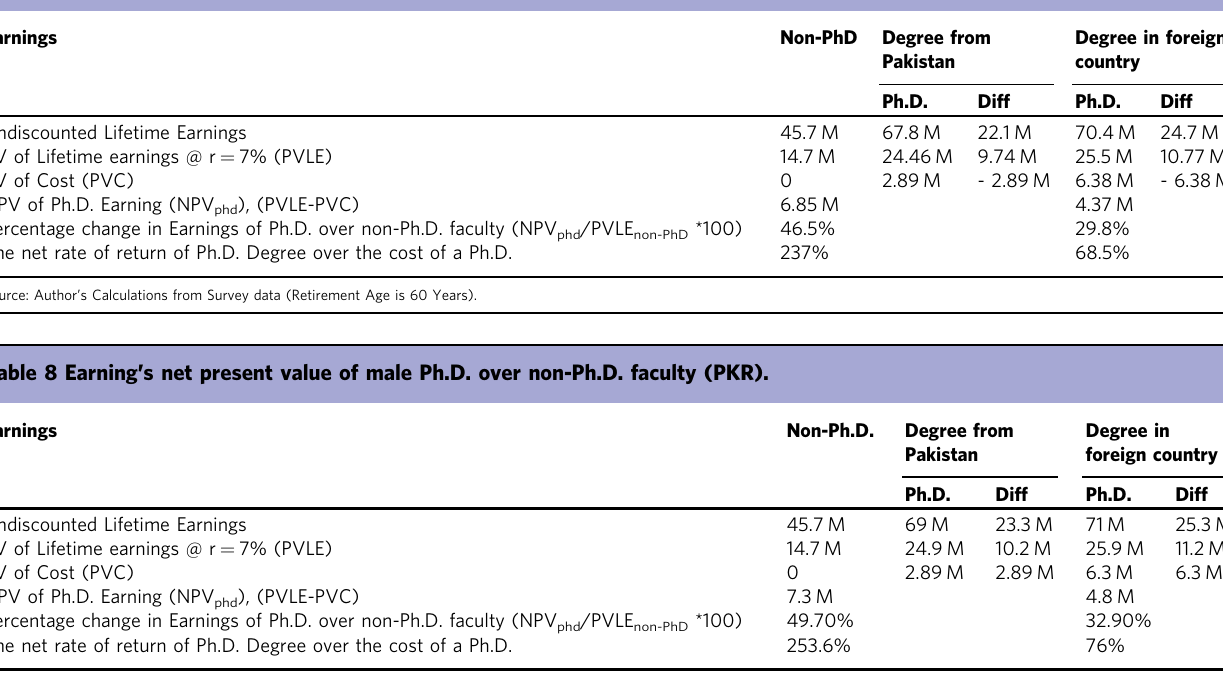
Table 7 Earning ’ s net present value of Ph.D. over non-Ph.D. faculty by country (PKR).